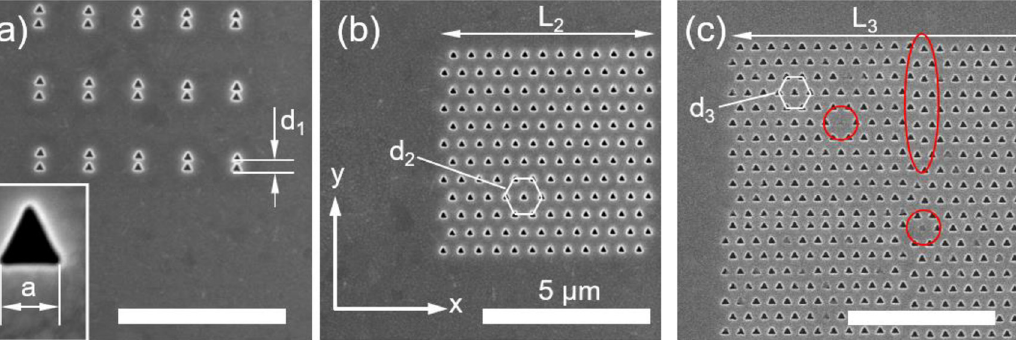
Figure2: (a – c)Scanningelectronmicrographsofdifferenttriangularholepatternswithabaselengthof a =180nmmilledintoa200nmthick Ag fi lm: (a) Dimers with variable inter-triangle separation d 1 , (b) a hexagonal nanohole array with a lattice constant of d 2 = 500 nm, and (c) a hexagonal nanoholearraywith thesameaveragelatticeconstant d 3 = d 2 butwith intentionally introducedlatticedefectsandstitchingerrors, indicatedinred.Theinsetin(a)showsamagni fi edviewofasingletriangularnanocavitywithasidelengthof a =180nm.Thescalebarineach image is fi xed to 5